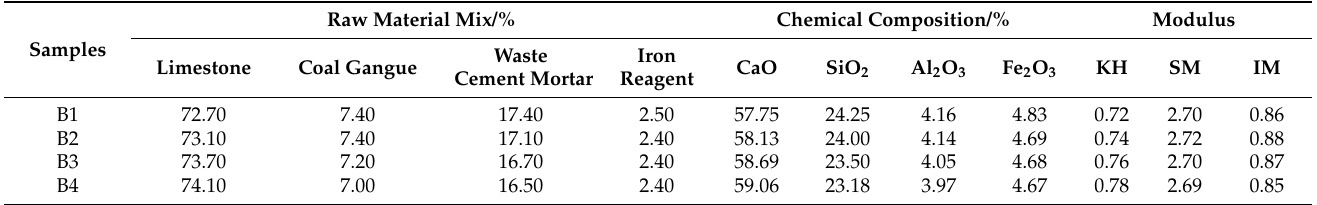
Table 3. The composition of high waste mortar raw meals without the addition of SO 3 in wt.% and expected basic chemical parameters.